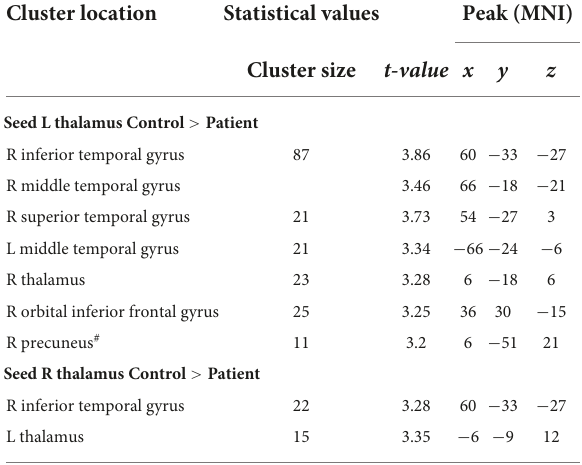
TABLE 2 Significant group differences in FC analysis. Cluster